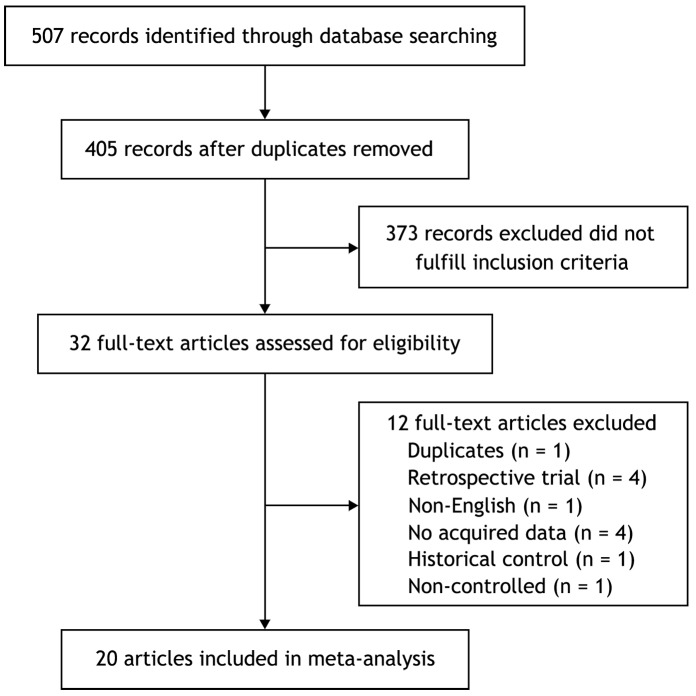
A flow chart showing the progress of trials through the review.